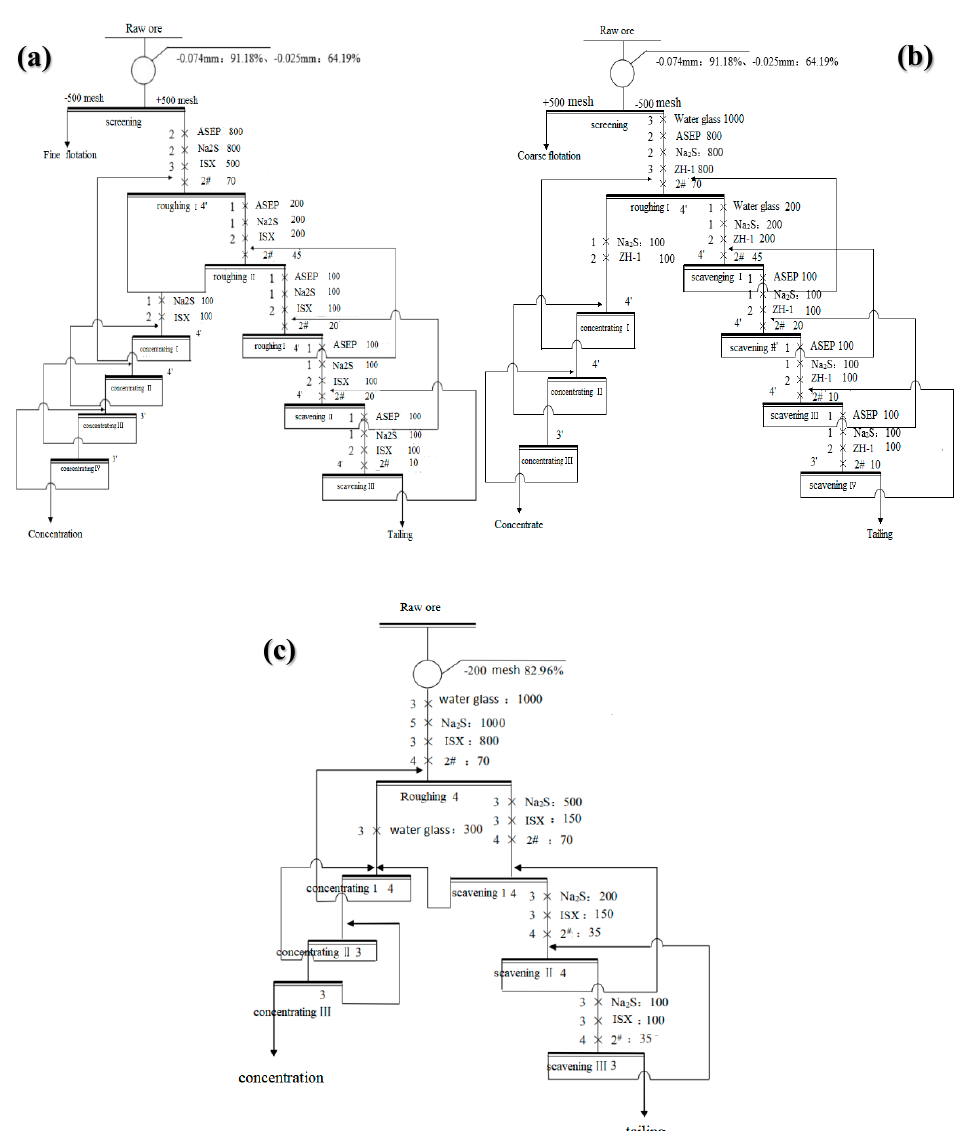
Figure 2. The batch flotation flowsheets of the ( a ) +25 µm; ( b ) − 25 µm and ( c ) − 74 µm ore ( c ) (the unit of dosage is g/t).